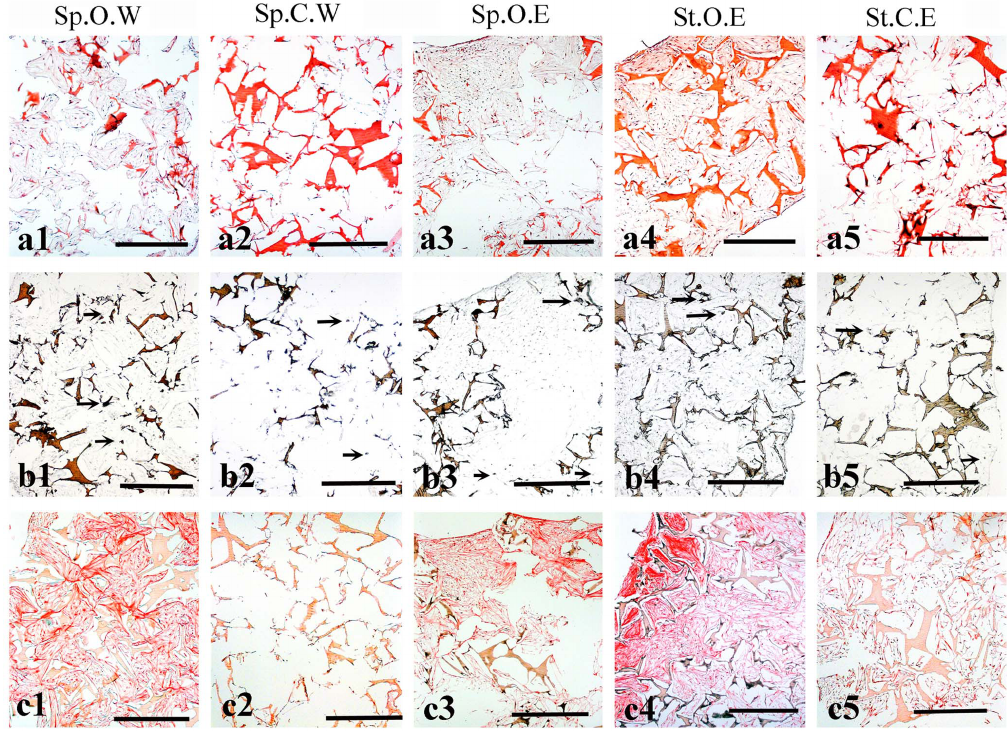
Figure 2. Histological analysis of hDPSCs seeded on silk fibroin scaffolds after 47 days of culture. ( a ) Haematoxylin and Eosin staining of histological sections from all groups. Extracellular matrix and silk scaffolds are stained red/pink. Cell nuclei are stained purple/violet. ( b ) Von Kossa staining. Silk scaffolds and mineralised nodules are stained in brown. Arrows indicate areas where phosphate is present. ( c ) Sirius Red staining showing the distribution of Collagen (red colour). Abbreviations: Sp.O.W: spinner flask culture in osteogenic medium with weekly x-ray; Sp.C.W: spinner flask culture in control medium with weekly x-ray; Sp.O.E: spinner flask culture in osteogenic medium with x-ray at the end; St.O.E: static culture in osteogenic medium with x-ray at the end; St.C.E: static culture in control medium with x-ray at the end. Scale bars: 500 m m.